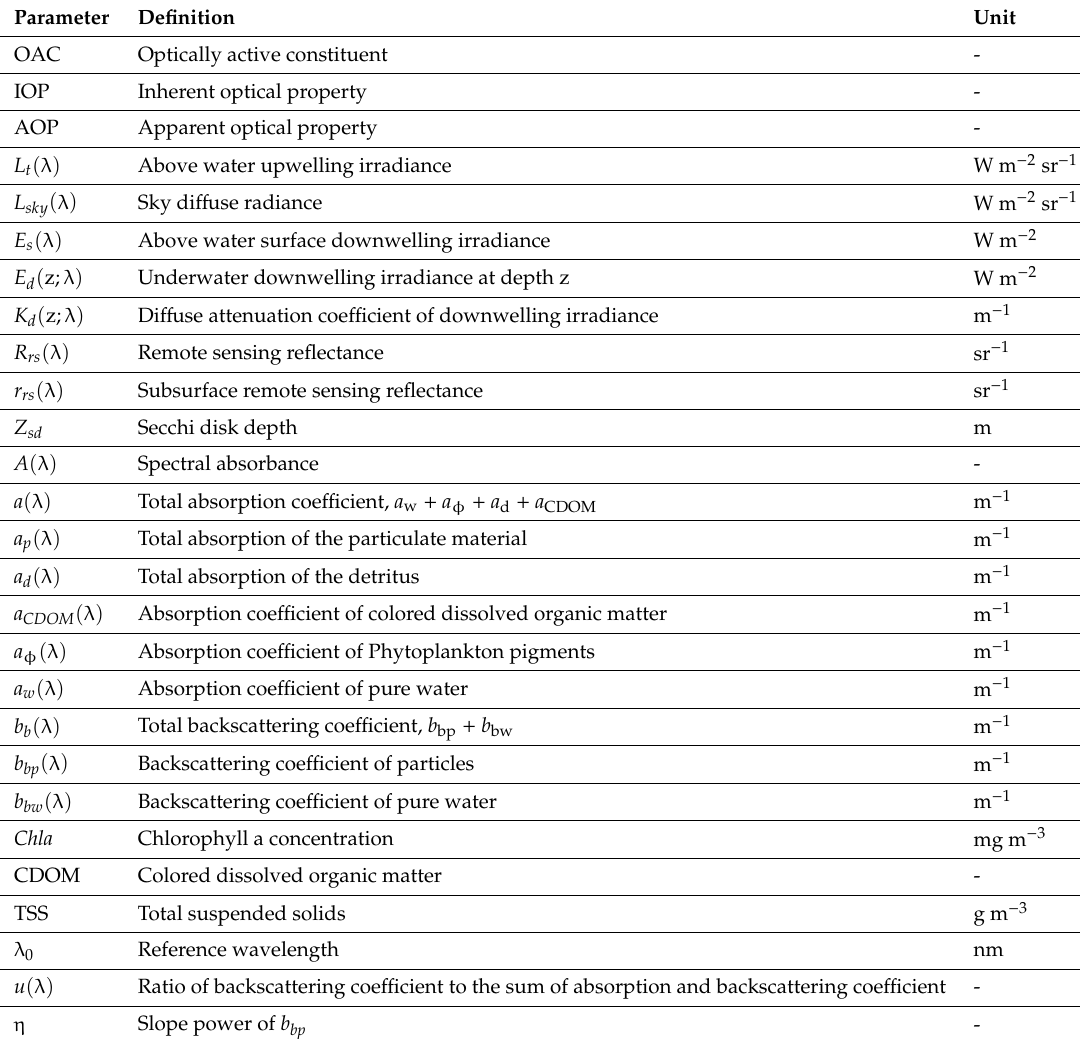
Table 1. Symbols and